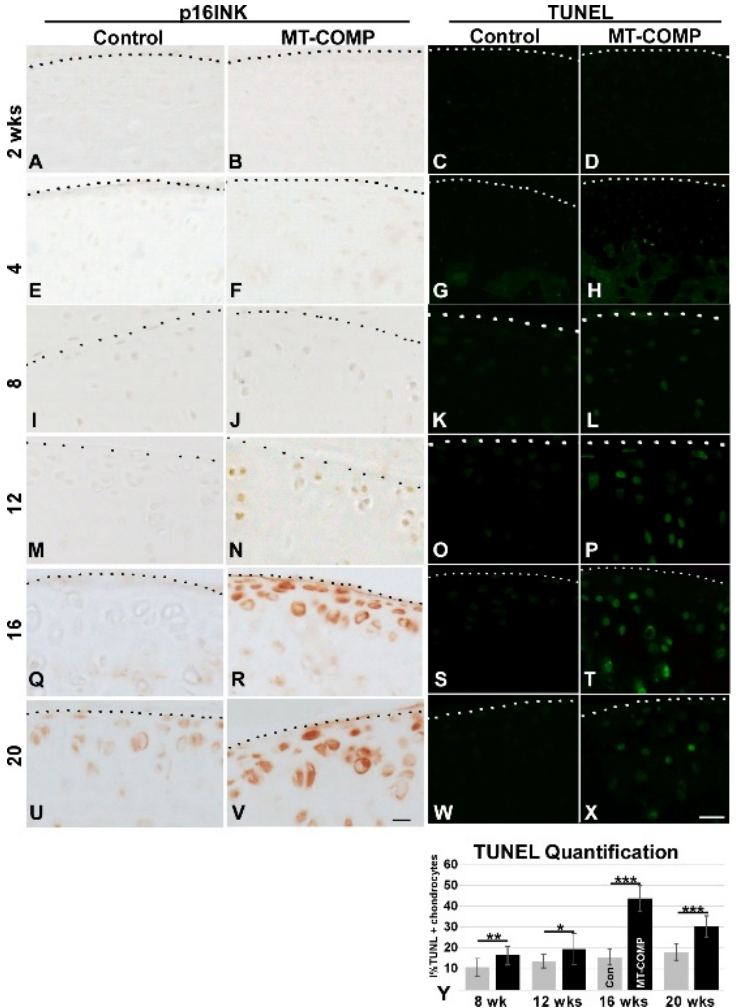
Figure 3. Articular chondrocyte senescence and death in MT-COMP mice. All mice were administered DOX from birth to collection at 2, 4, 8, 12, 16, and 20 weeks. Dotted line marks the edge of articular cartilage. Control and MT-COMP tibial articular cartilage were immunostained using p16 INK4a antibodies (brown A , B , E , F , I , J , M , N , Q , R , U , V ). p16 INK4a expression is present from 12–20 weeks ( N , R , V ). TUNEL staining (green) is shown in C , D , G , H , K , L , O , P , S , T , W , X . The MT-COMP mice show numerous TUNEL positive articular chondrocytes ( L , P , T , X ) compared to the controls ( C , G , K , O , S , W ). Percent TUNEL positive MT-COMP articular chondrocytes are shown at 8, 12, 16, and 20 weeks. MT-COMP TUNEL staining is significantly different than the controls * p < 0.05; ** p < 0.005; *** p < 0.0005 ( Y ). Sections from the hind limb articular cartilage of at least 10 animals per group were stained with TUNEL. Bar = 100 µ